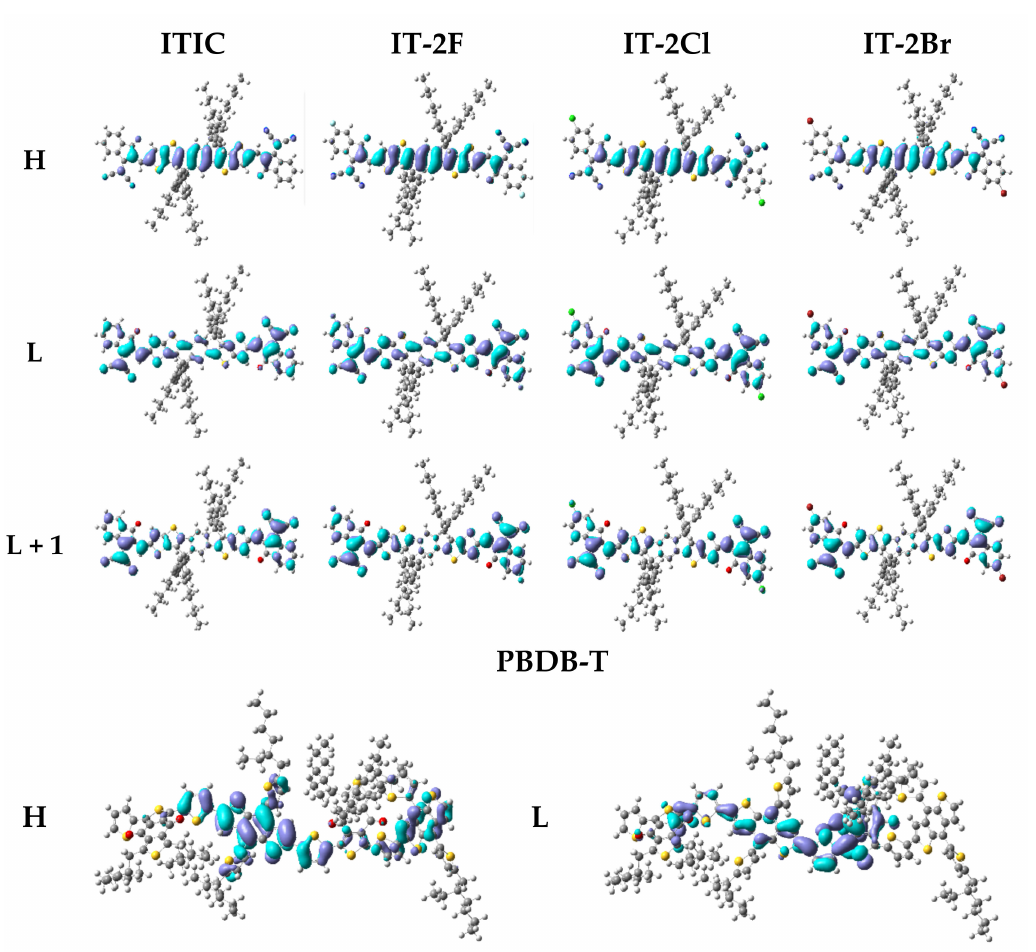
Figure 3. The selected frontier molecular orbitals for the ITIC, IT-2X (X = F, Cl, Br) and PBDB-T. (LC-PBE/6-31G**, ω = 0.155, 0.167, 0.144, 0.155, 0.155 Bohr − 1 ; α = 0.200, β = 0.086; ε s = 3.5, ε d = 3.3; H = HOMO, L =